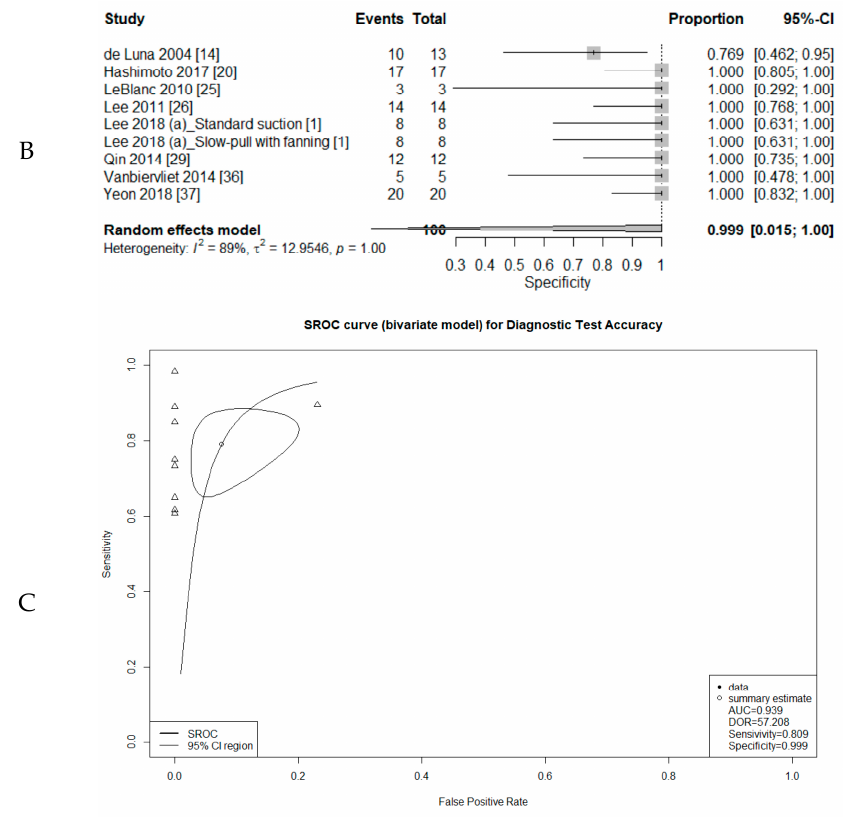
Figure 3. Forest plot diagram of the pooled sensitivity ( A ), specificity ( B ), and summary receiver operating characteristic (SROC) curve ( C ) in liquid-based preparation. (Triangle, estimate of each study)